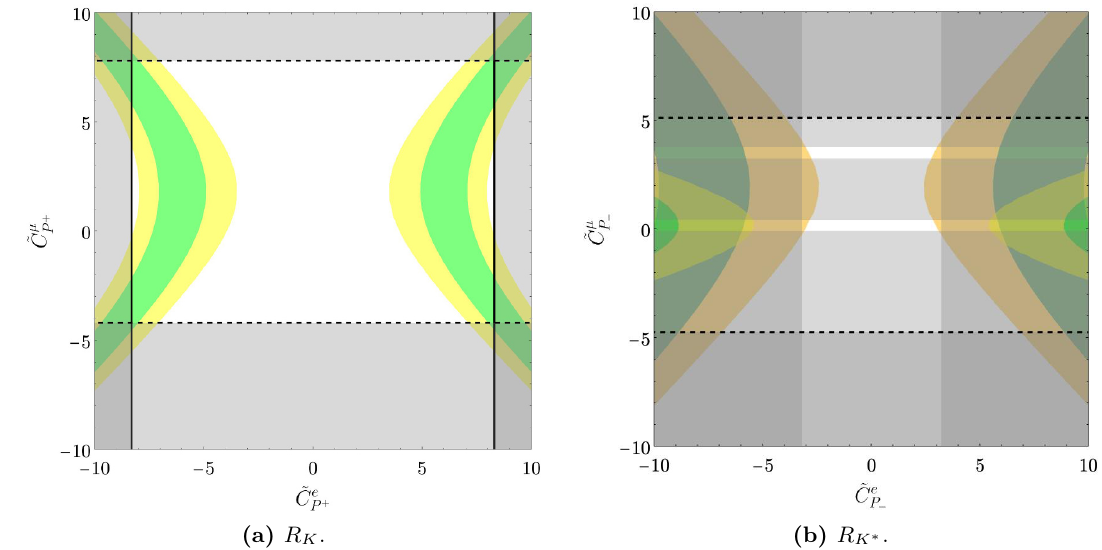
Figure 13. Parameter space for R K (left) and R K ∗ (right) for an ALP lighter than 2 m µ . In light yellow and light green are respectively depicted the 1 σ and 2 σ solutions to the central bin of R , while darker shades of those colours on the right plot denote the corresponding solutions K ∗ for the low bin of R . The grey regions around the frame of the figures are excluded at 2 σ by K ∗ data on semileptonic B → K ( ∗ ) µ + µ − (dashed black contours) decays, and on the left plot also by B → Ke + e − data (solid black contours). On the right plot, regions excluded by purely leptonic B s decays reach the central area and are also depicted in